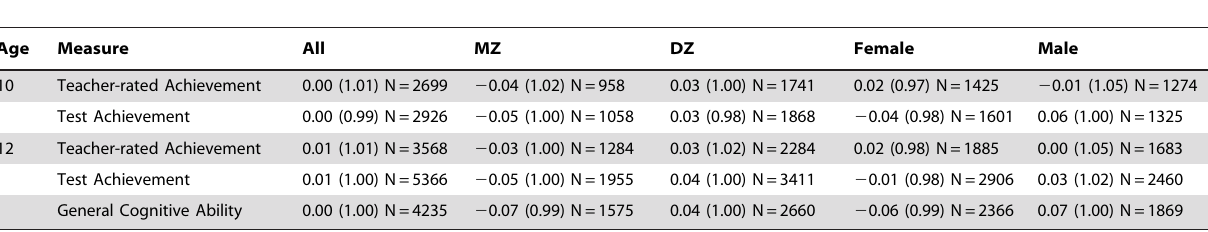
Table 1. Means (and standard deviations), by zygosity and